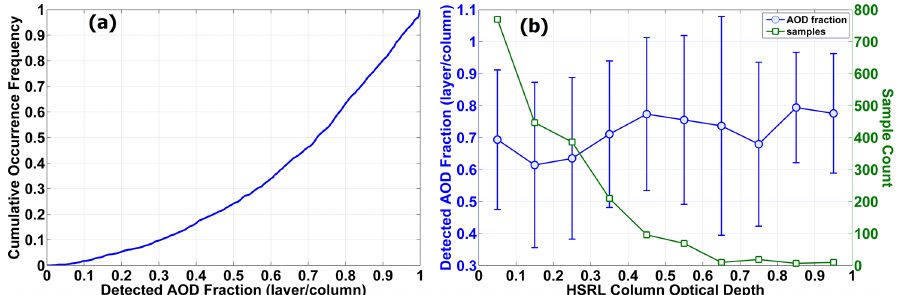
Figure 8. (a) Cumulative distribution of detected AOD fraction (layer/column); and (b) detected AOD fraction as a function of column AOD (blue) with number of samples (green). Error bars in (b) represent the single sample SD.